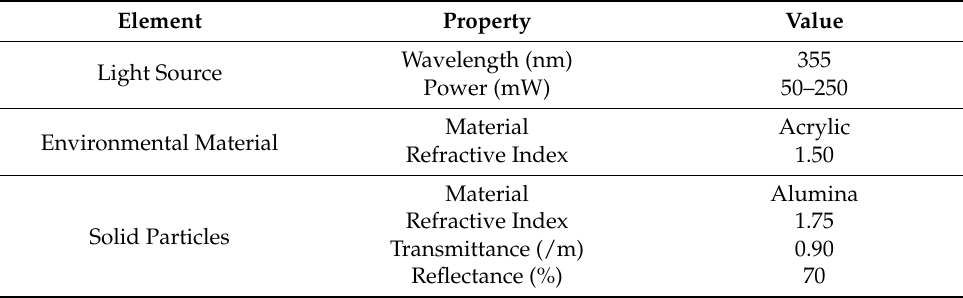
Solid Particles